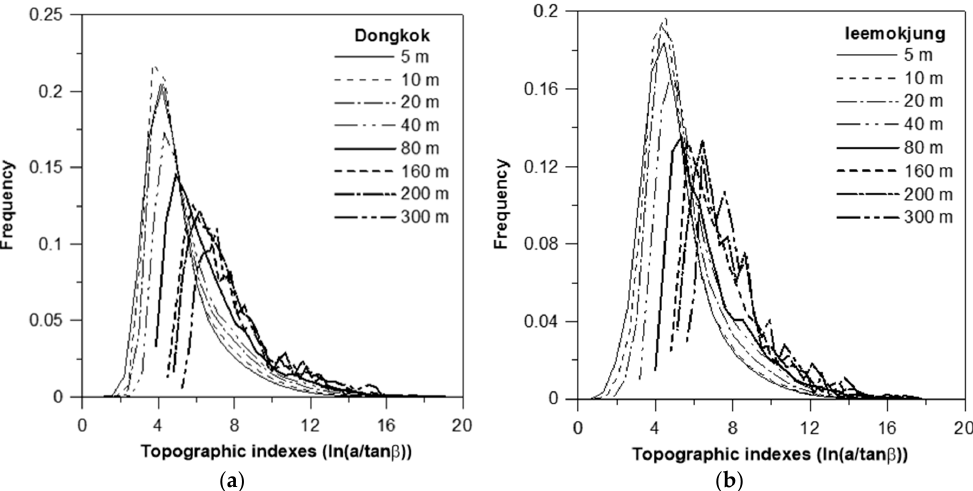
) ) based on the DEM grid cell size. (cid:3047)(cid:3028)(cid:3041)(cid:3081) tan β